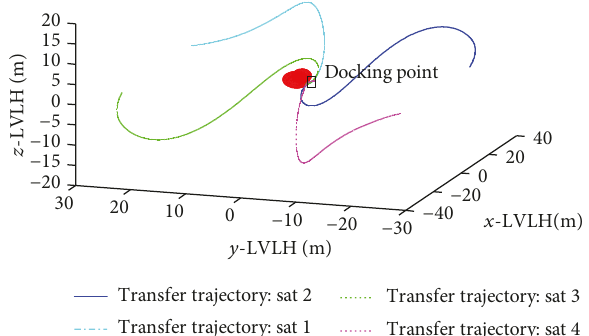
and control horizon N on (a) convergence time and (b) total control input. p c